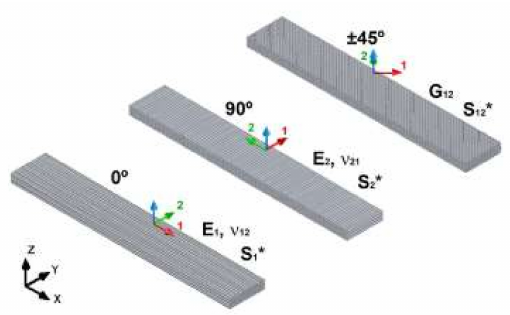
Figure 4. Illustration of printing orientations (0 ◦ , 90 ◦ , and ± 45 ◦ )